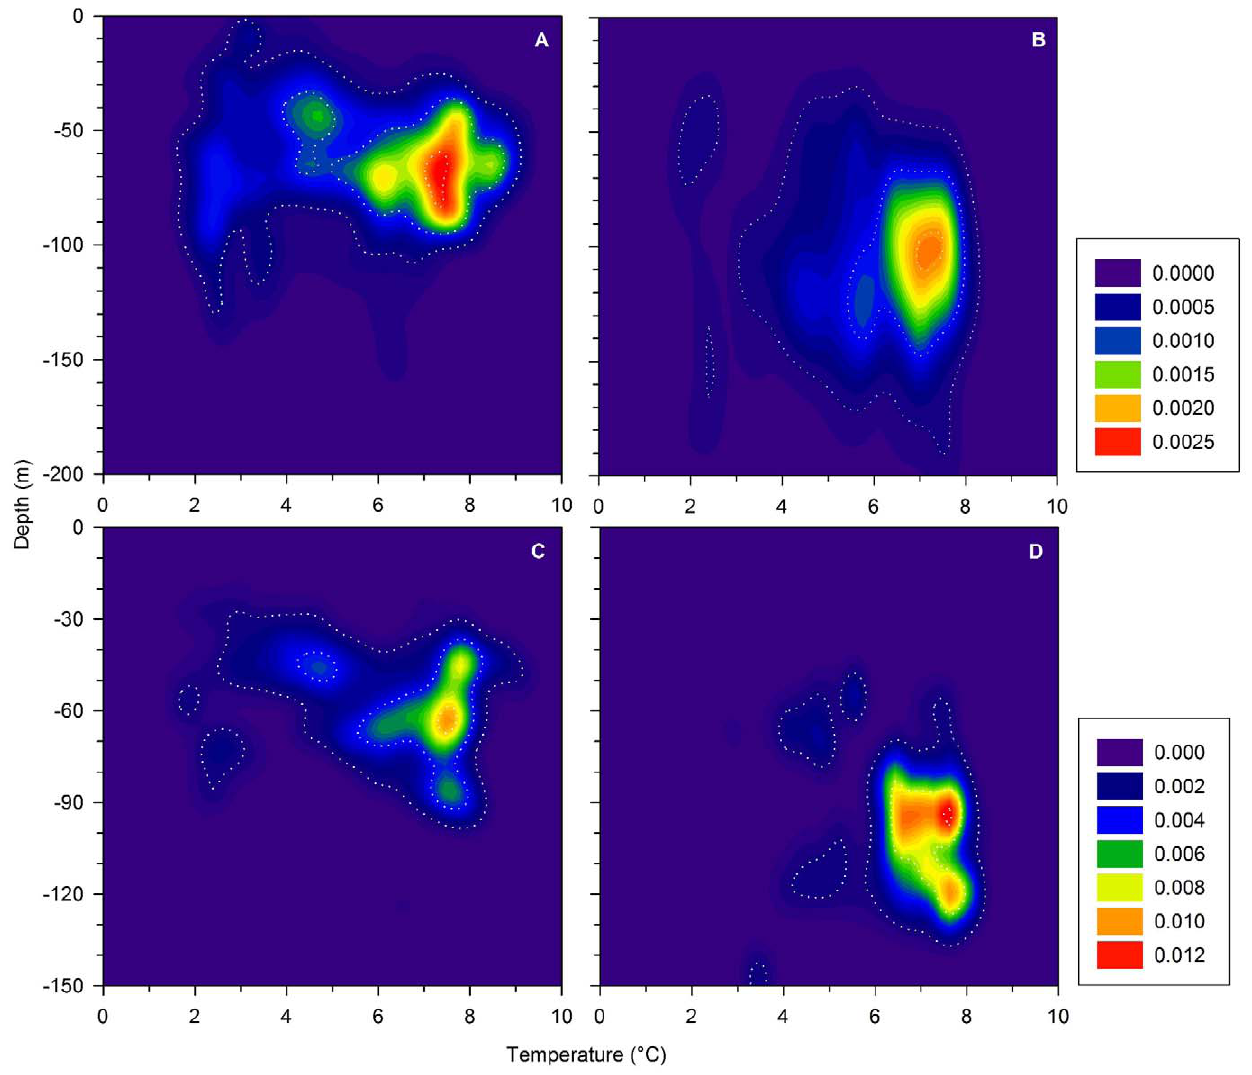
Figure 4. Bivariate kernel density estimates of thermal-bathymetric niches occupied during potential spawning activity of Atlantic cod. Thermal-bathymetric niches occupied during the spawning season as defined as the period between the end of in-migration and outmigration (A, B) and for periods of inferred presence in a spawning aggregation as indicated by the presence of a clear tidal signature during the spawning season (C, D) are presented for southern coastal (A, C) and frontal (B, D) behavioral types in the Icelandic stock of Atlantic cod. Dotted lines enclose the 95 th , 50 th , and 10 th percentiles of the distributions.